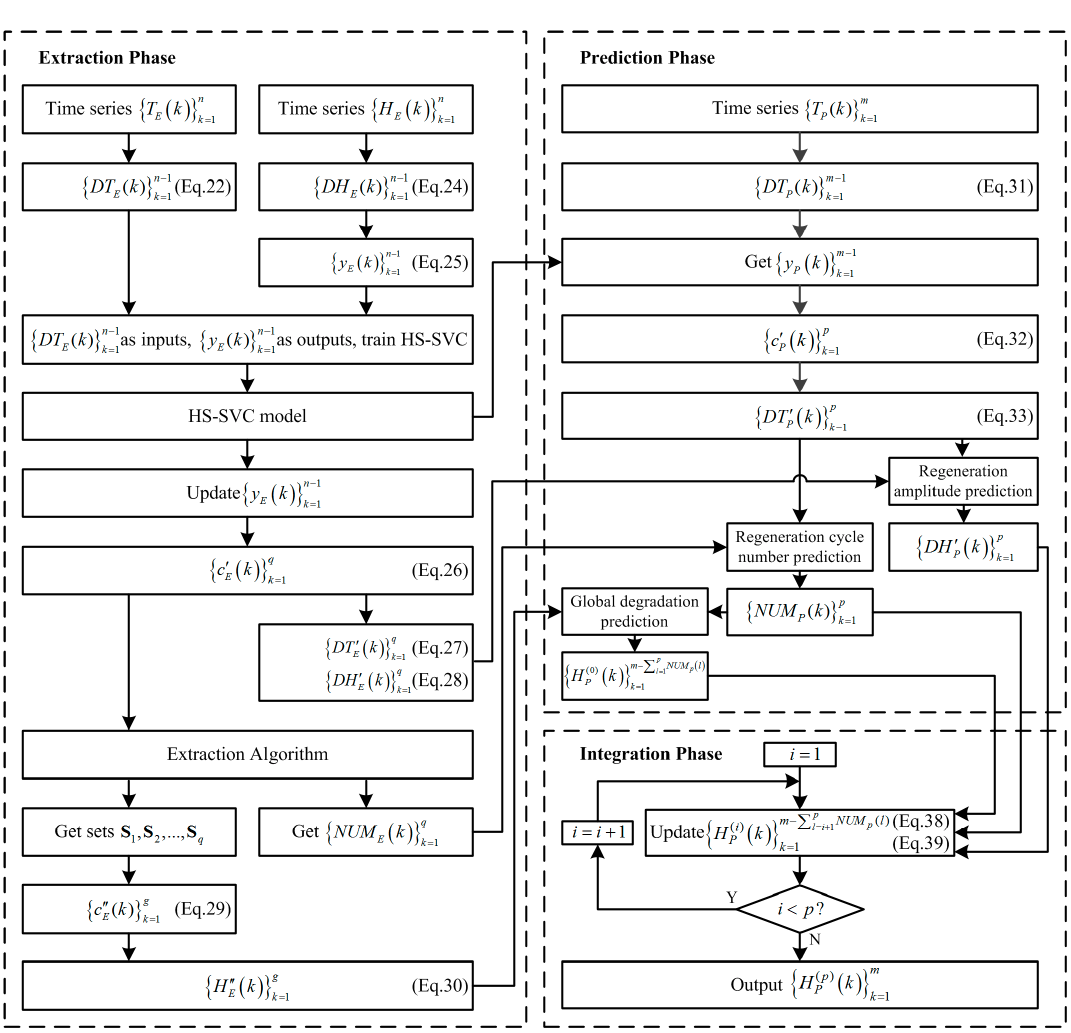
Figure 4. Framework of rest time-based prognostic strategy.